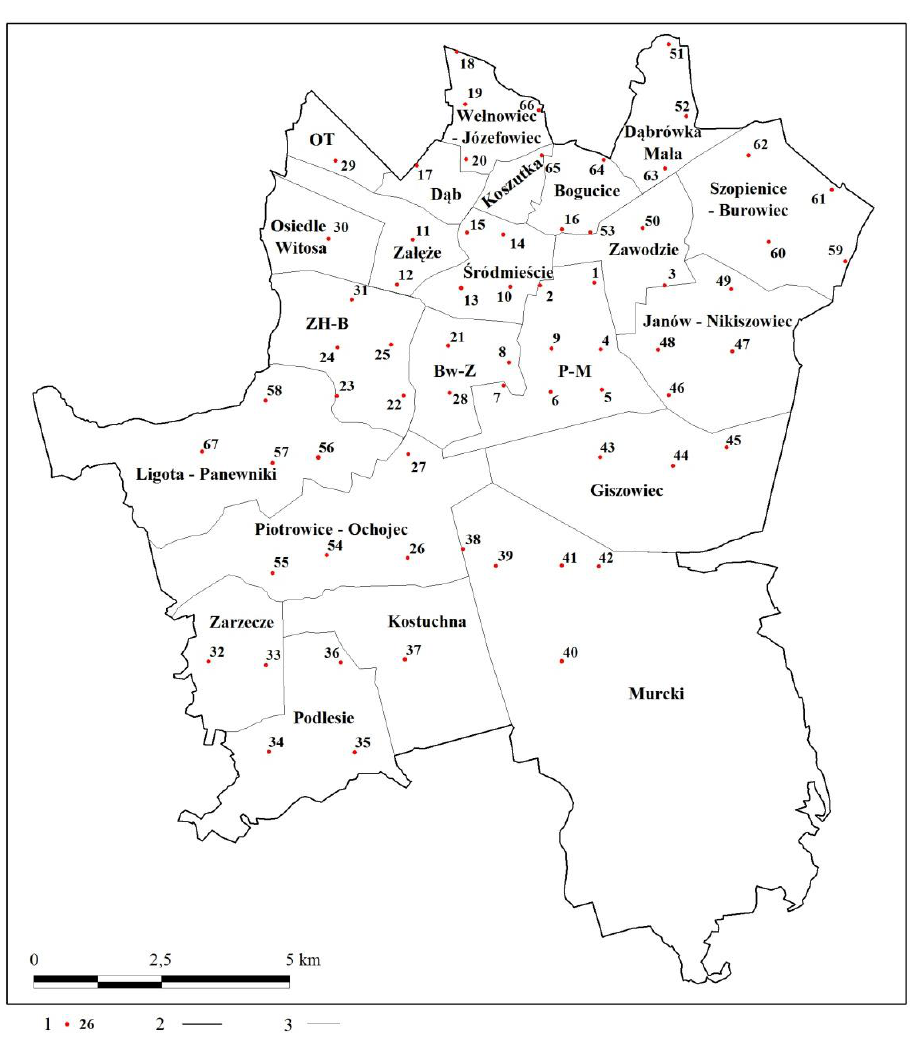
Fig. 1. Location of the collection points within the city of